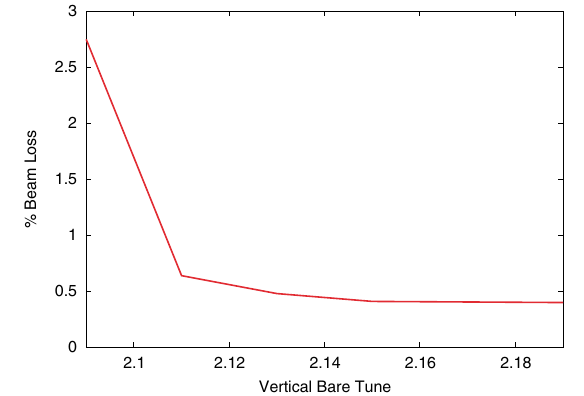
(cid:5) 3 : 19 ; (cid:4) (cid:5) 2 : 09 ; . . . ; 2 : 19 (cid:4) , x y decreases from 2.19 to y